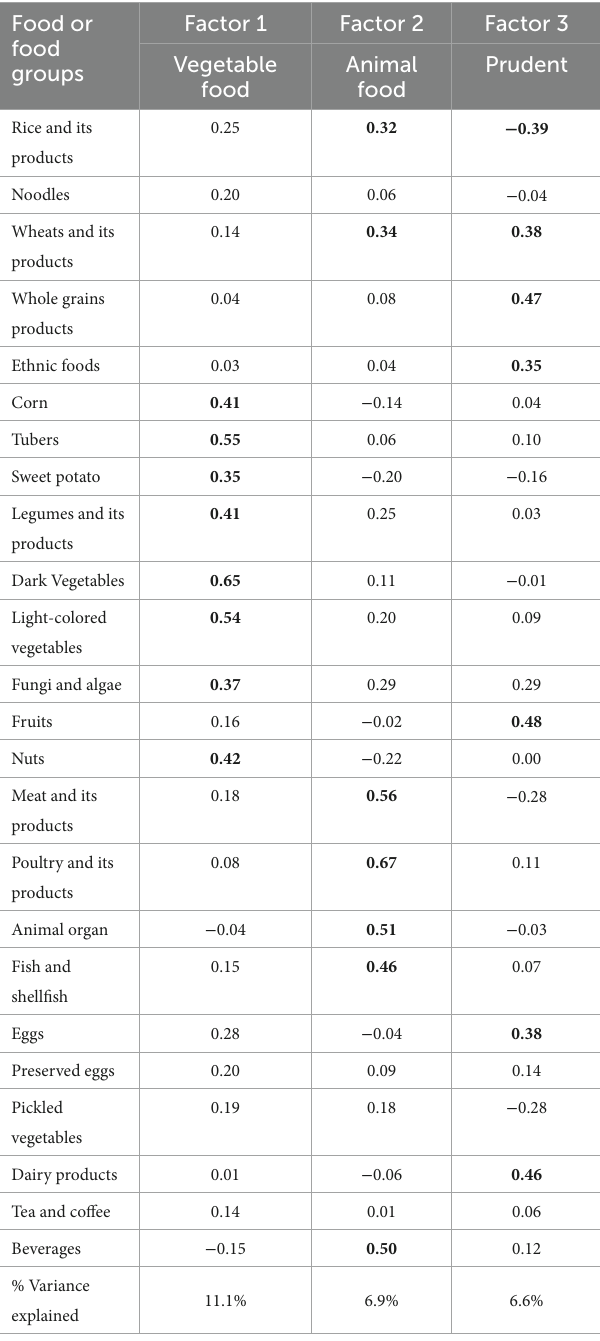
TABLE 2 Orthogonally rotated factor loadings for three dietary patterns derived from factor analysis a